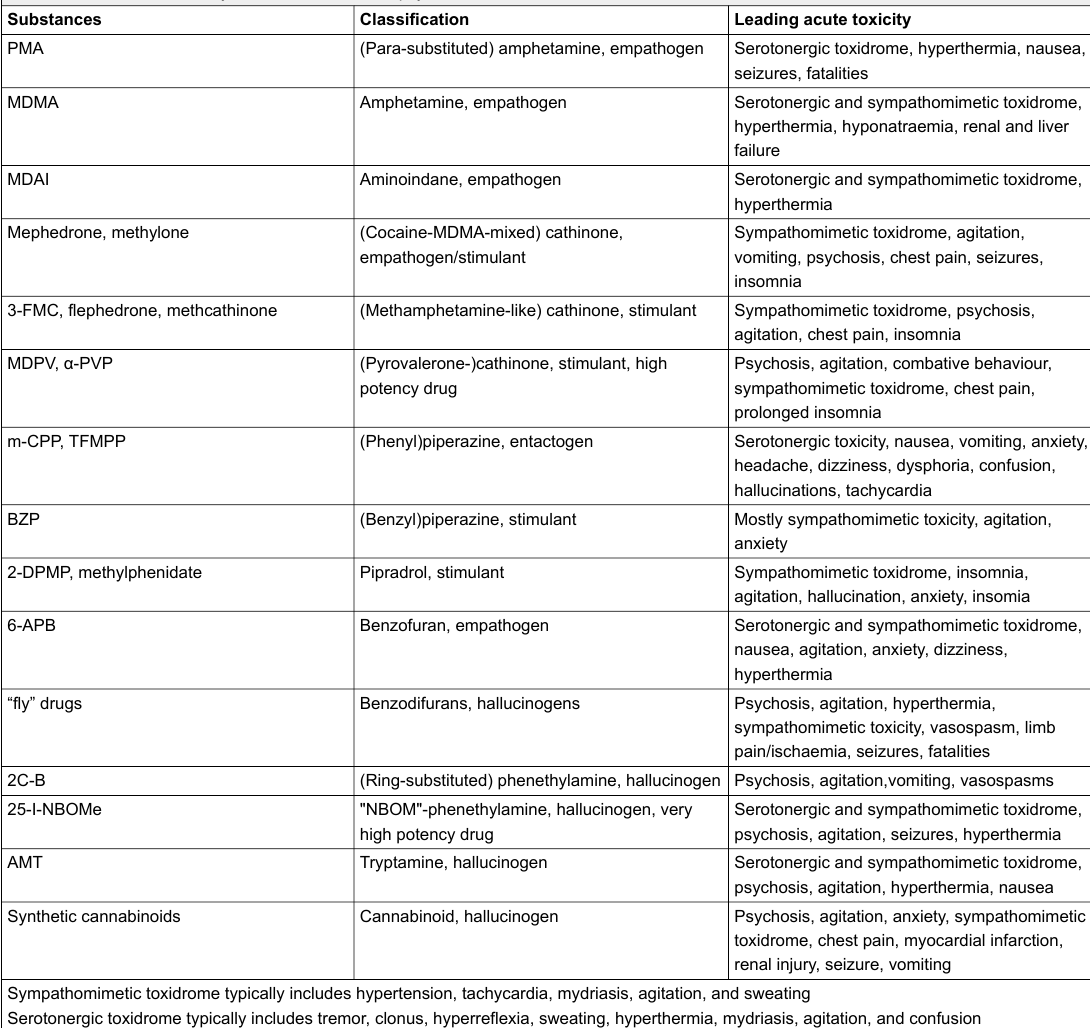
Table 2: Acute clinical toxicity associated with novel psychoactive substances.